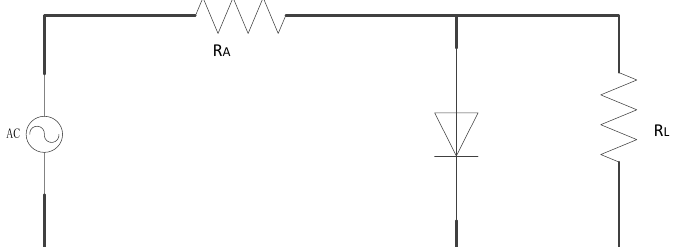
Figure 6. Shunt diode limiter circuit.